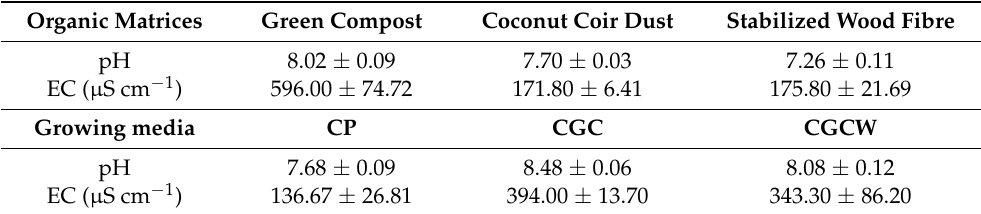
Table 1. Baseline values of pH and electrical conductivity (EC) of both tested matrices and growing media. CP: coconut coir dust:pumice, CGC: coconut coir dust:green compost, CGCW: coconut coir dust:green compost:stabilized wood fibre, CE: electrical conductivity. Values represent mean ± standard deviation calculated of three replicates. Organic Matrices Green Compost Coconut Coir